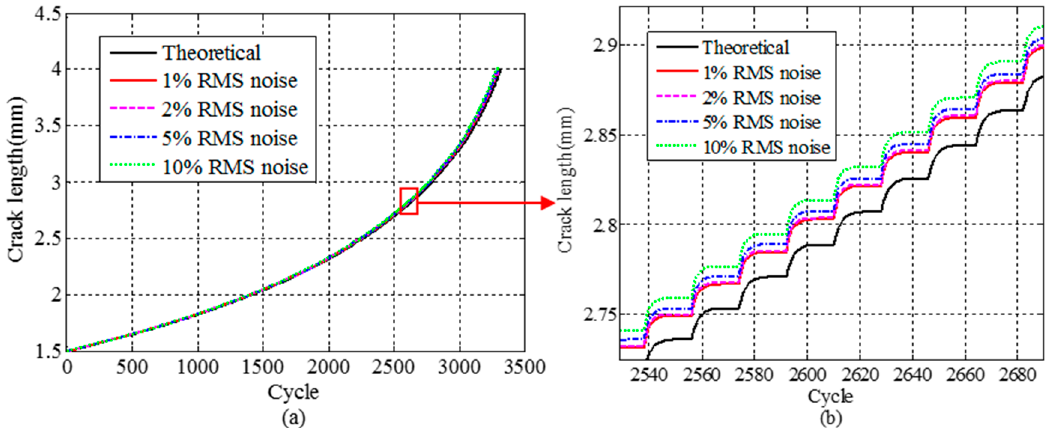
Figure 14. Crack growth trajectories calculated using theoretical and reconstructed stress responses under different RMS noise levels. ( a ) Entire 3500 cycles crack growth trajectories; ( b ) crack growth trajectories (2532–2684 cycles).